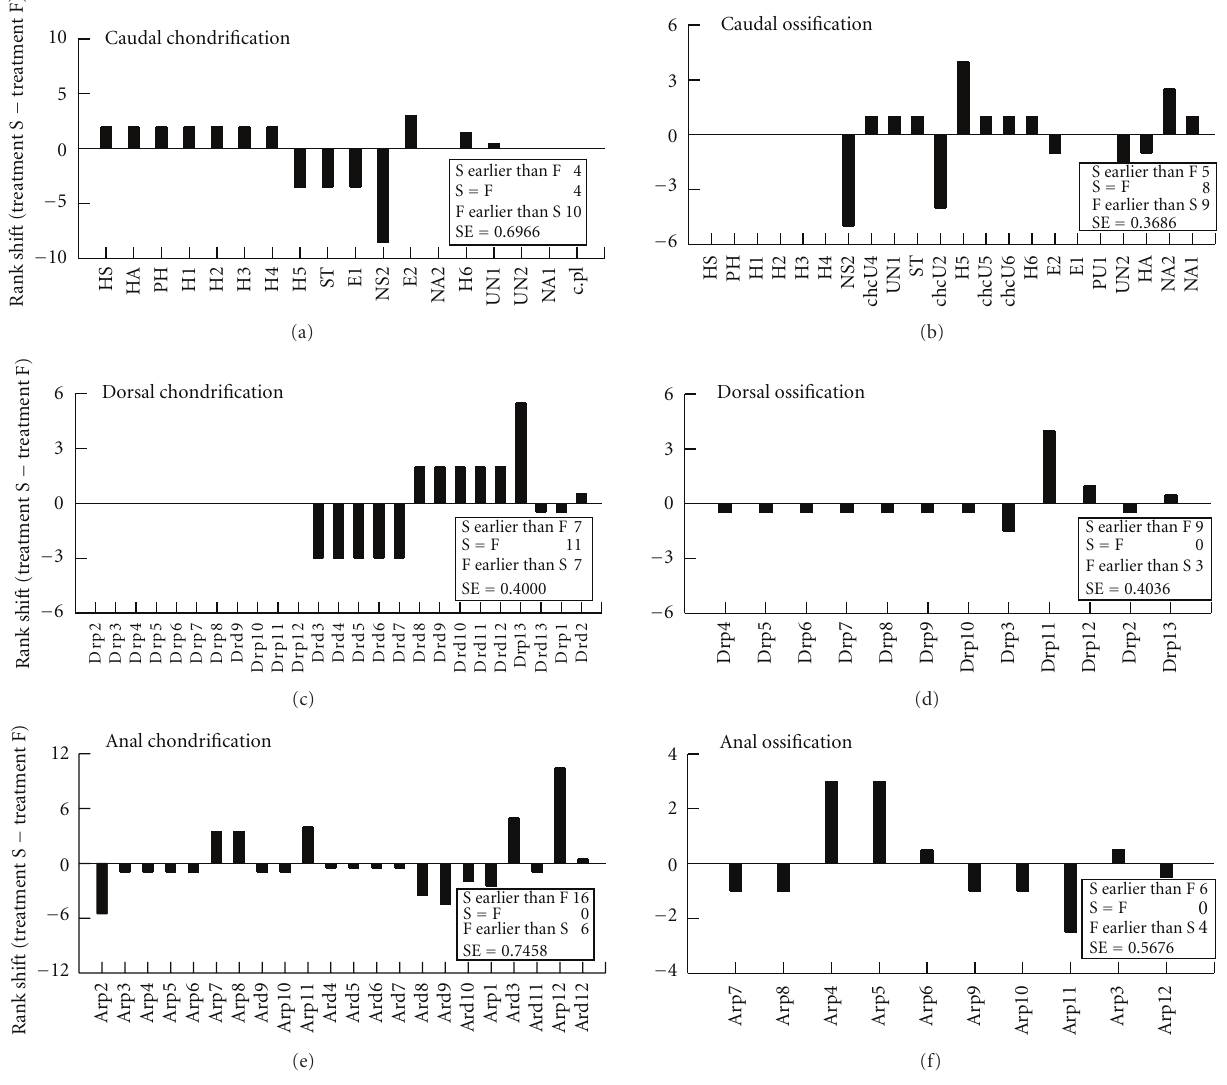
Figure 6: Histograms of magnitude of rank shifts for the chondrification (a, c, e) and ossification (b, d, f) of the three median fins [caudal (a, b), dorsal (c, d) and anal (e, f)] in Salvelinus alpinus . Rank shifts are calculated as the di ff erence of rank from treatment S to treatment F. Elements are listed in the order of their appearance in treatment S. Numbers of relative shifts and standard errors on the average rank shifts are provided for each